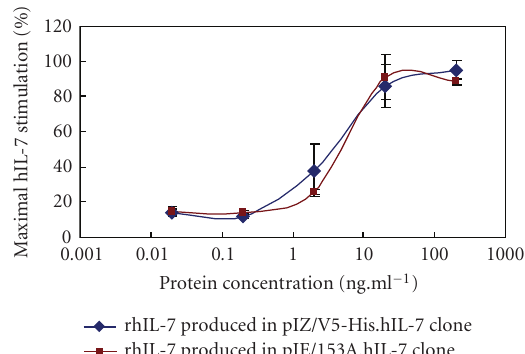
Figure 6: Biological activity assay of recombinant human IL- 7 produced in insect cells. IL-7-dependent murine immature B lymphocyte cell line 2E8 was used for proliferation assay. After 72 hours incubation at 37 ◦ C in a 5% CO 2 atmosphere, cell proliferation was detected by tetrazolium compound MTS and an electron coupling reagent PMS. The absorbance of the formazan was measured at 490 nm. Commercially available rhIL-7 was used to establish the 2E8 bioassay. Medium alone served as a negative control, and each sample was assayed in triplicate ( n = 3).